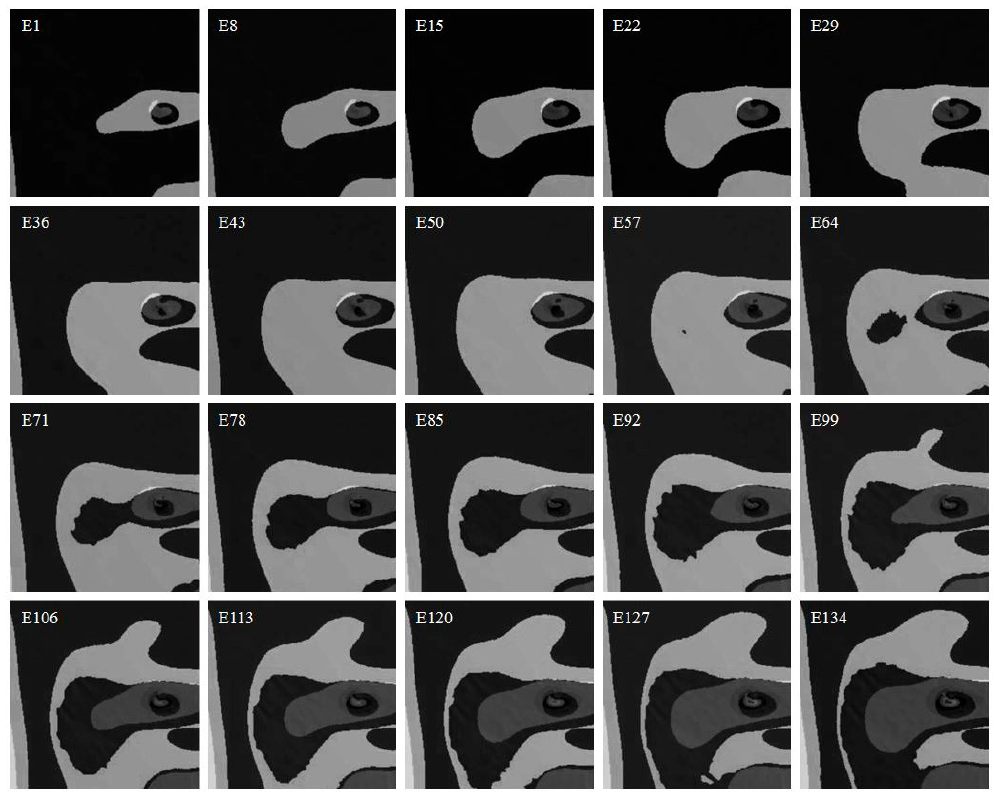
Figure 4. Equivalent stress deviation images of Part 1 in gray.